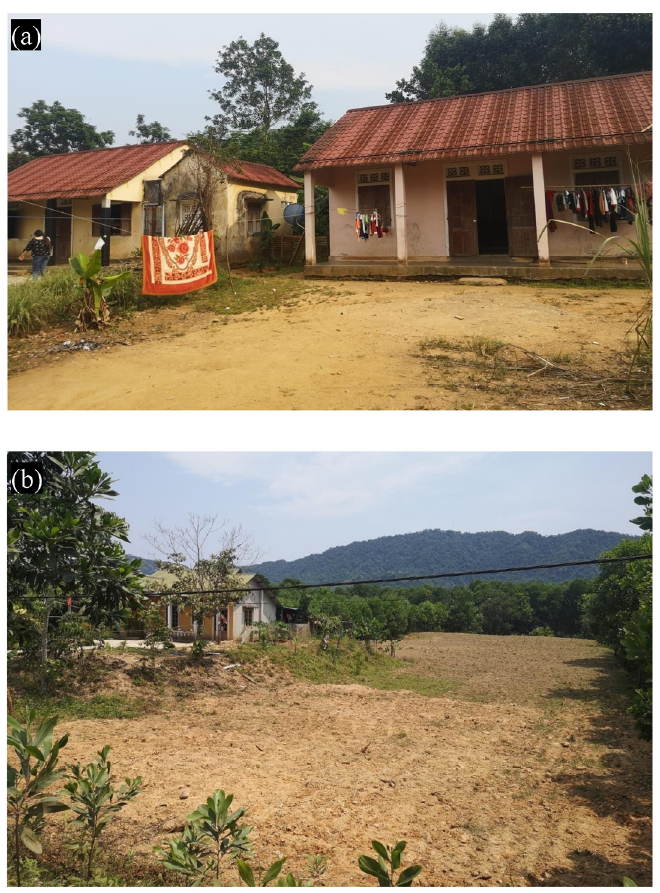
Figure 10. ( a ) Houses in Bo Hon village, and ( b ) house in A Sap village.